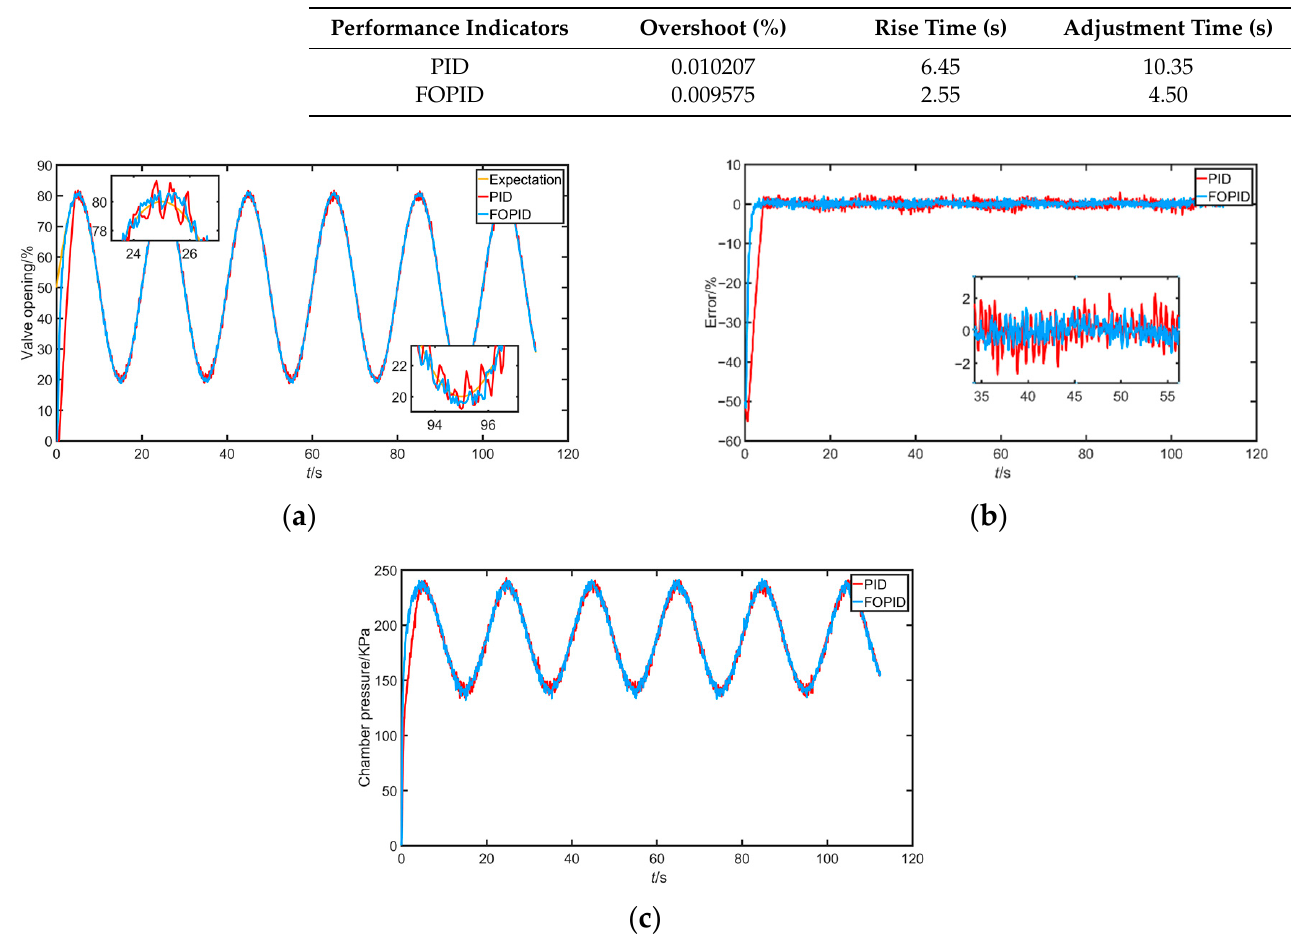
Table 4. The corresponding performance indicators of the two algorithms at 50% opening. Performance Indicators